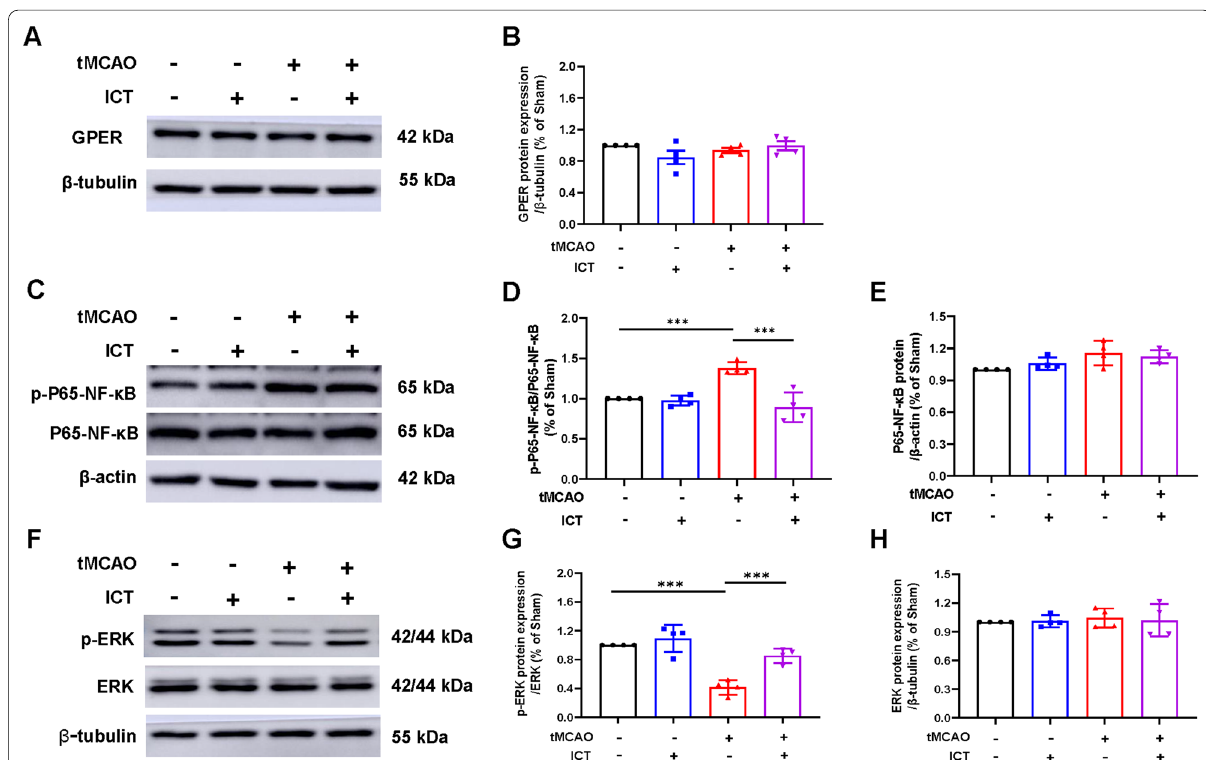
Fig. 4 The expression levels of GPER, P65-NF-κB, ERK and the phosphorylation level of P65-NFκB, ERK are regulated by ICT treatment after CI/RI. A – H The protein expression of GPER, p-P65-NF-κB, P65-NF-κB, ERK and p-ERK (n